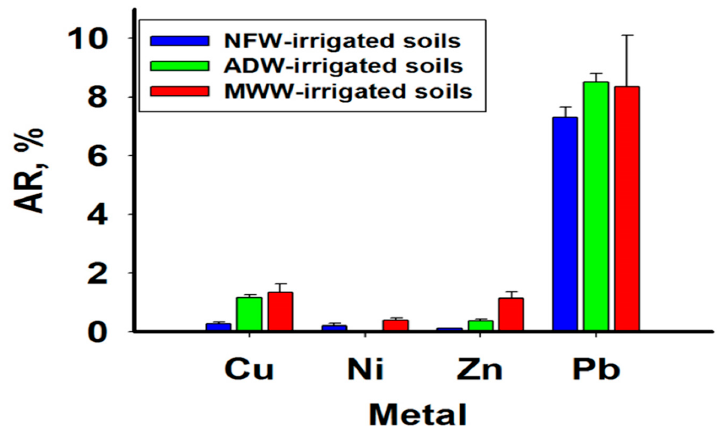
Figure 4. Metal availability ratio (AR).